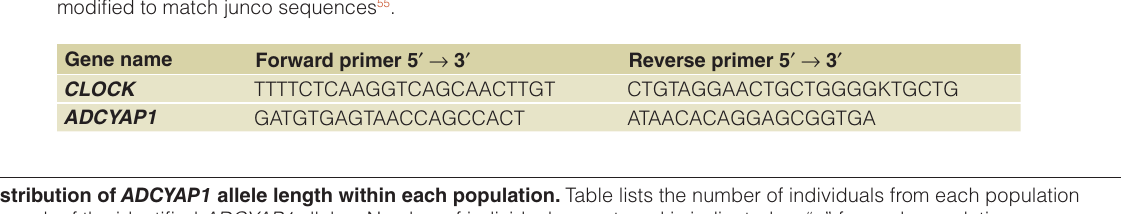
Table 2. Primers used in this study. Both primers are based on Steinmeyer et al. 43 , and CLOCK was modified to match junco sequences 55 .